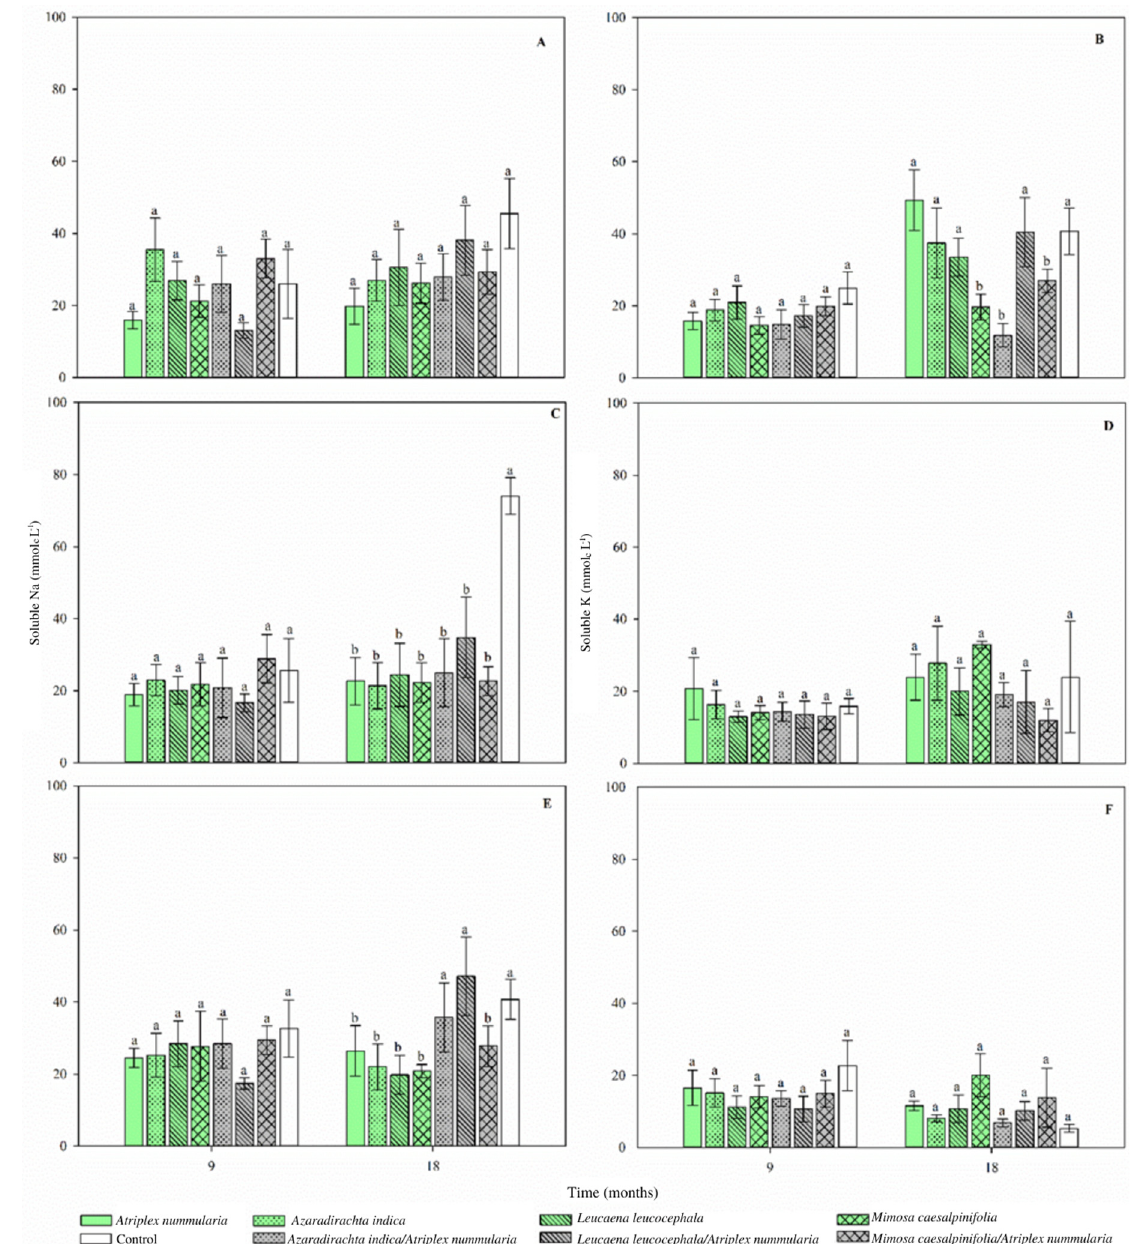
Figure 4. Soluble Na + [( A ) 0–10 cm; ( C ) 10–30 cm; ( E ) 30–60 cm] and soluble K + [( B ) 0–10 cm; ( D ) 10–30 cm; ( F ) 30–60 cm] at 9 and 18 months as result of the applied treatments. (Averages of four replications). Averages followed by the same letter have no difference in the same layer and time of sampling by the Skott-Knott test ( p ≤ 0.05).